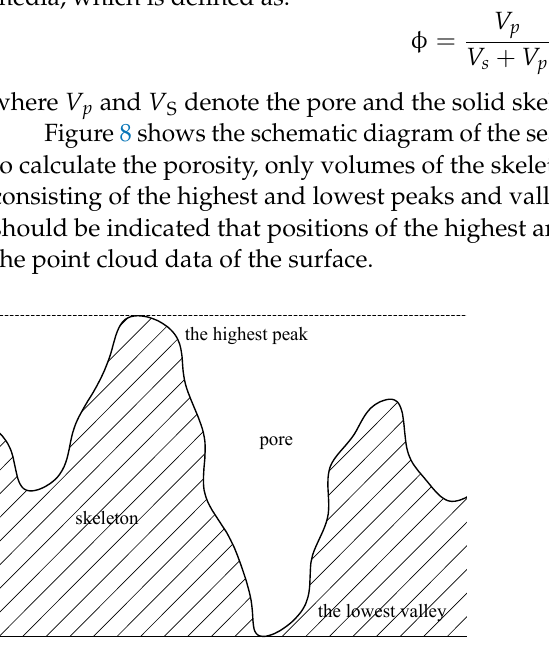
Figure 8. Shape diagram of the surface on the static ring.